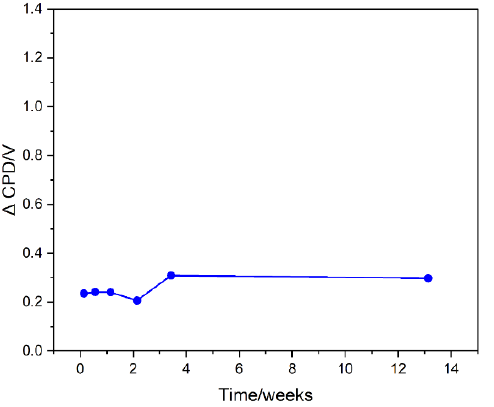
Figure 2. Contact potential difference of 10 min oxygen plasma ‐ treated graphite immersed in water.